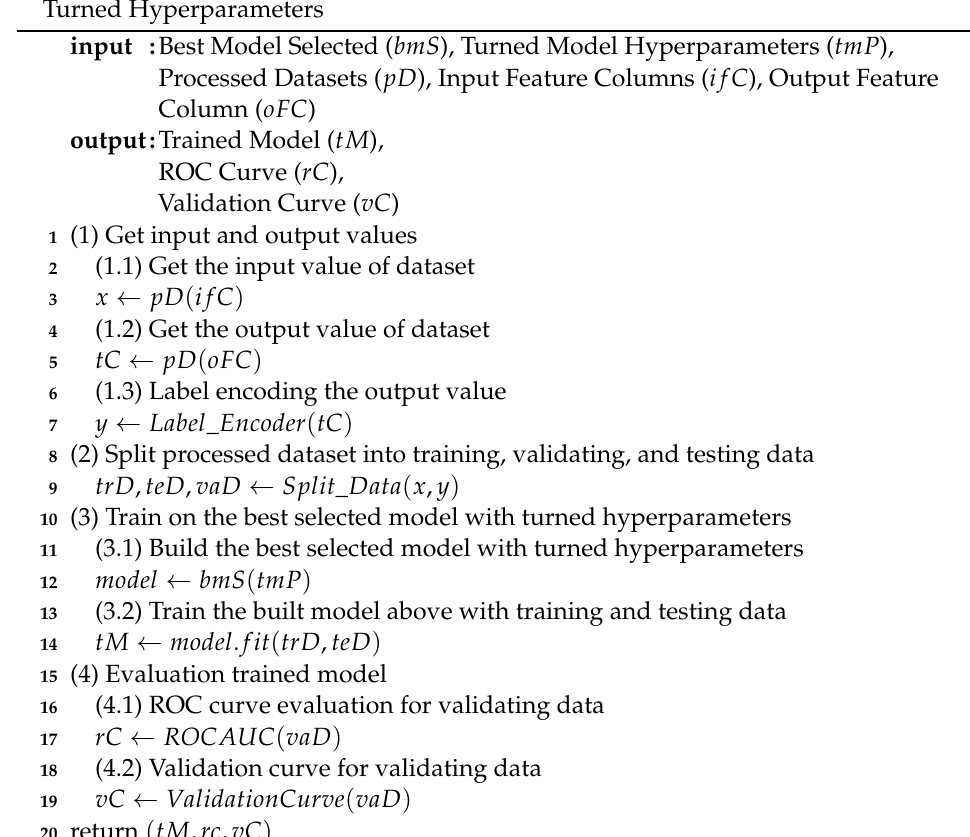
Algorithm 2: Training and Evaluation Process of the Best Selected Models with Turned